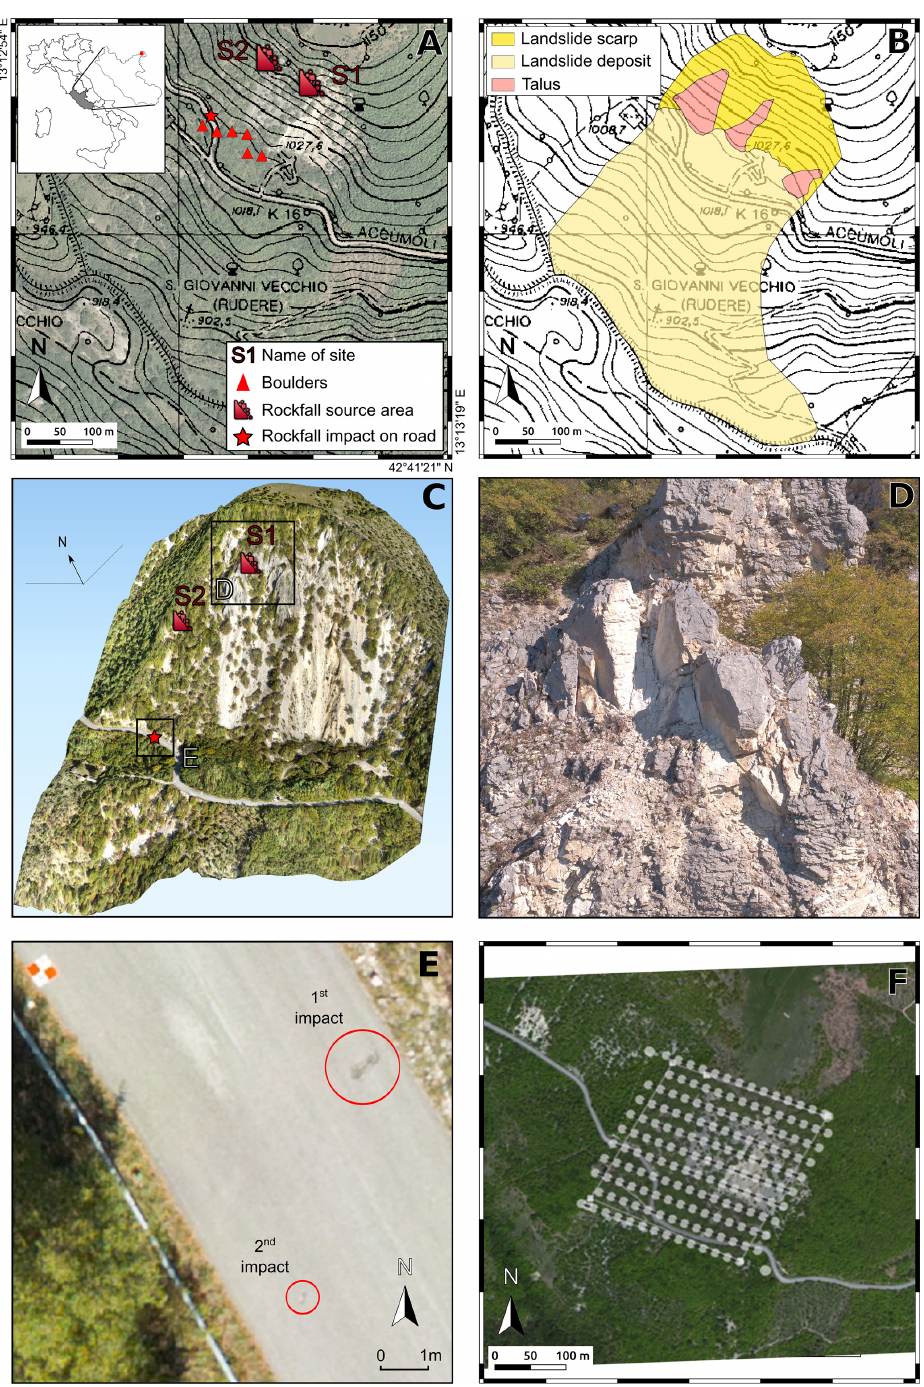
Figure 1. Location of the study area. (a) Topographic map: Carta Tecnica Regionale of the Lazio region, at 1 : 10000 scale. Colour orthophoto map: Ortophoto 50cm copyright 2012 AGEA – all rights reserved. Symbols named S1 and S2 indicate the source areas of the fallen boulders. The red star shows the location where a boulder hit and crossed the SP18 road. Red triangles indicate the boulders found at the farthest locations from the source areas along the talus slope during the field survey. (b) Map of surface deposits obtained through the visual interpretation of the available aerial photographs. (c) Three-dimensional perspective of the study area. Image base and elevation data were obtained ad hoc through a RPAS flight carried out on 10 October 2016. (d) S1 rockfall source area. Oblique photograph taken by the RPAS. (e) Detail of the orthophotograph obtained by the RPAS showing impact points of the boulder detached from the S2 source area. (f) Flight plan of the multicopter for the acquisition of aerial